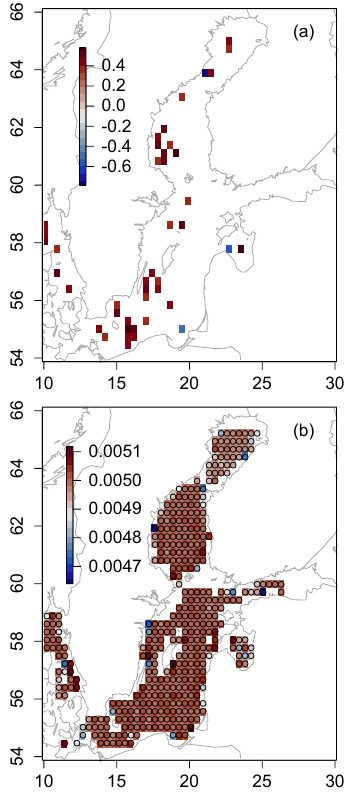
Figure 5. Spatial variability of wave climate in the Baltic Sea. (a) Mann–Kendall tau statistics of trends in SWH in the Baltic Sea in 1996–2015, winter months, from altimetry measurements (pixel size 0.4 × 0.3 ◦ ). The data are shown only for a statistically signifi- cant (at a >95% level) increase or decrease in the SWH. (b) Trends found in synthetic data generated for the same positions and times as the studied satellite altimetry dataset in 1996–2015 (pixel size 0.4 × 0.3 ◦ ). The data were created to uniformly follow a positive trend of 0.005myr − 1 . Open circles indicate statistically significant trends (at a >99%